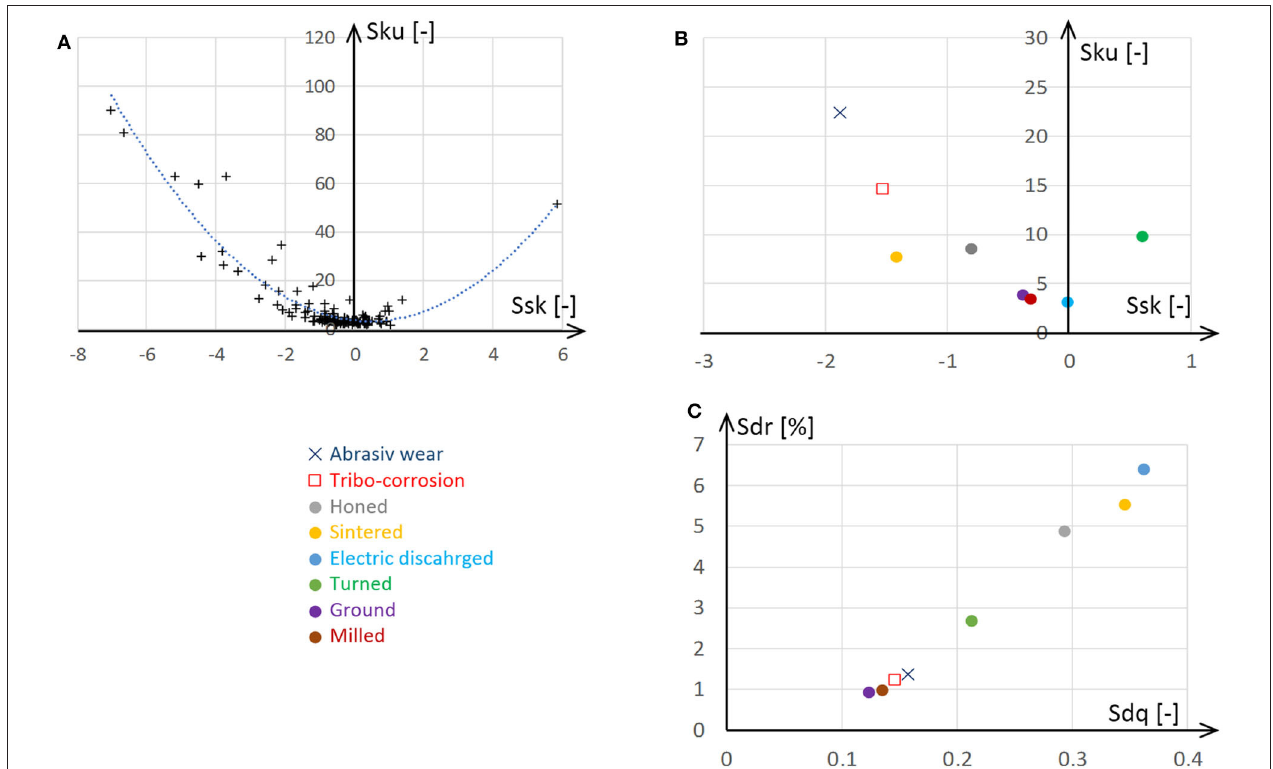
FIGURE 2 | (A) Ssk-Sku map for all the examined topographies; (B) Ssk-Sku map with the average of categories; (C) Sdq-Sdr map with the average of categories.